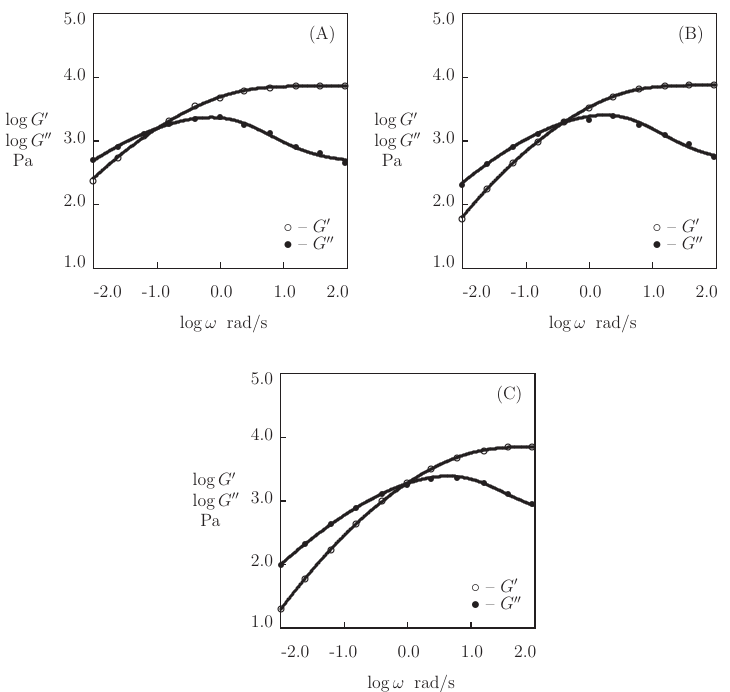
Figure 16. Storage modulus G (cid:48) and loss modulus G (cid:48)(cid:48) versus frequency ω . Symbols: experimental data [74] on o-Cys-P 4 -Cys gel (mass fraction of proteins 0.1) at various temperatures T (( A )– T = 15, ( B )– T = 25, ( C )– T = 35 ◦ C). Solid lines: the results of simulation.